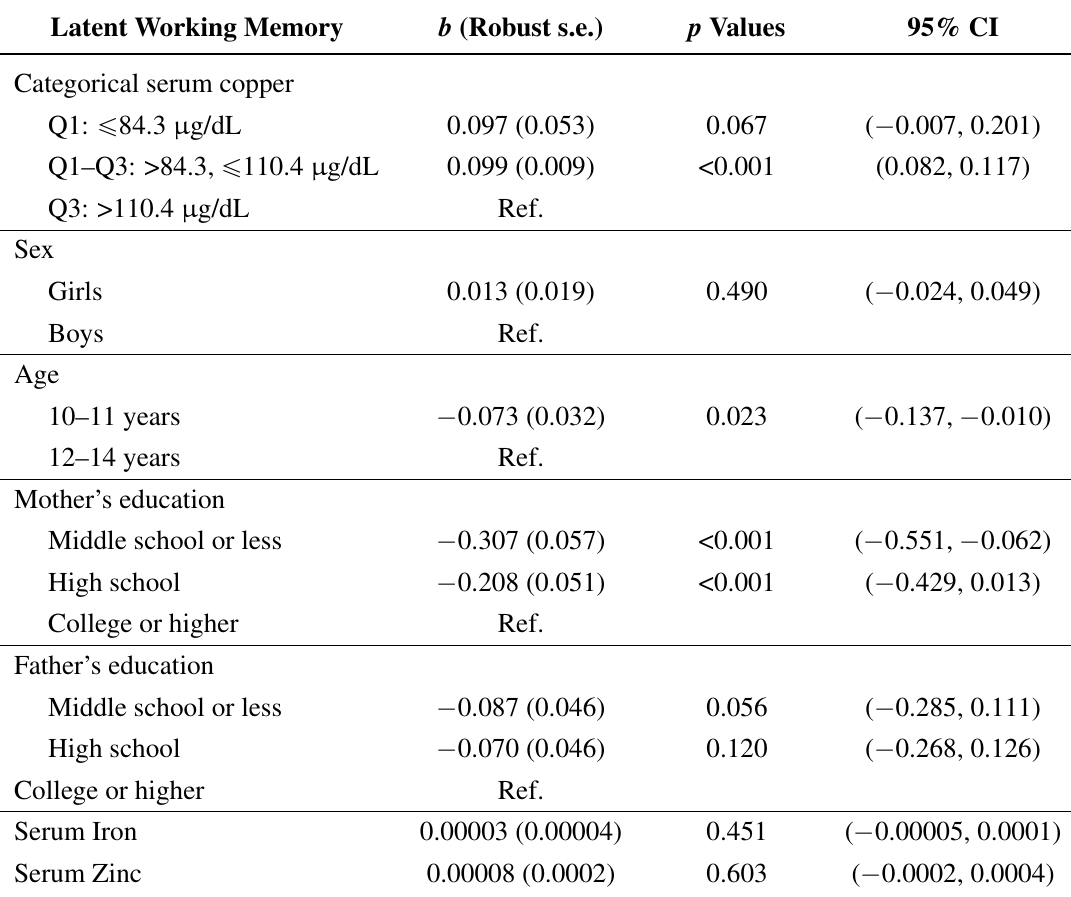
Table 3. The regression models of association of working memory with